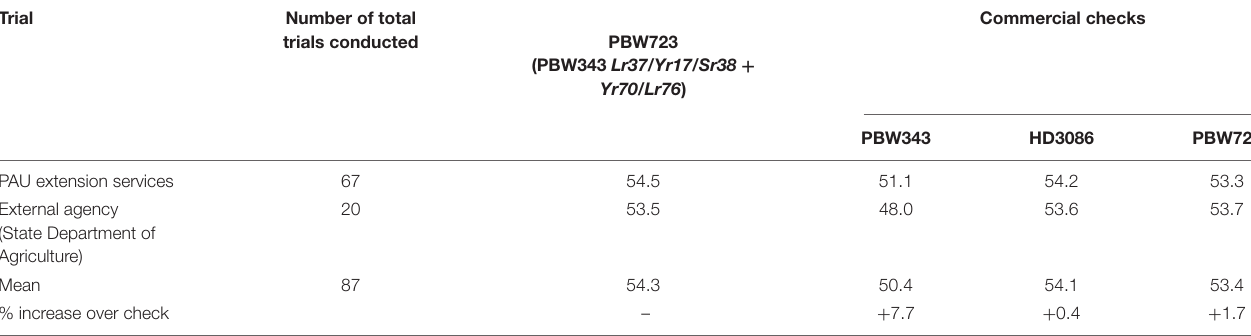
TABLE 8 | Evaluation summary of PBW723 in farmers’ fields during year 2016–2017.